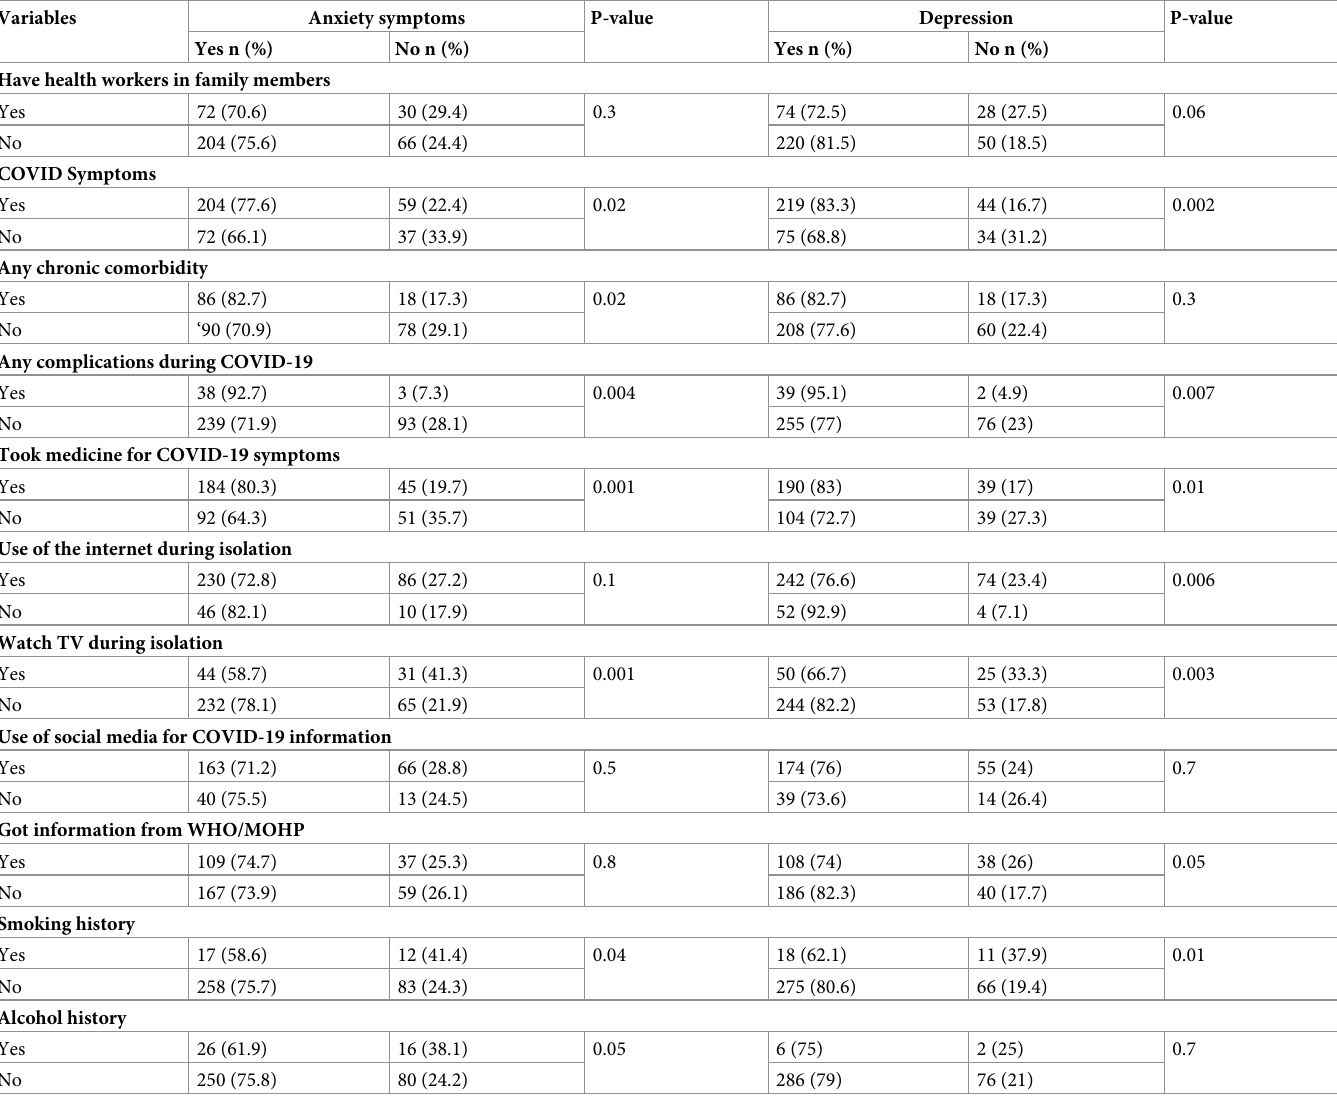
Table 3. General COVID-19 related and behavioral characteristics of the